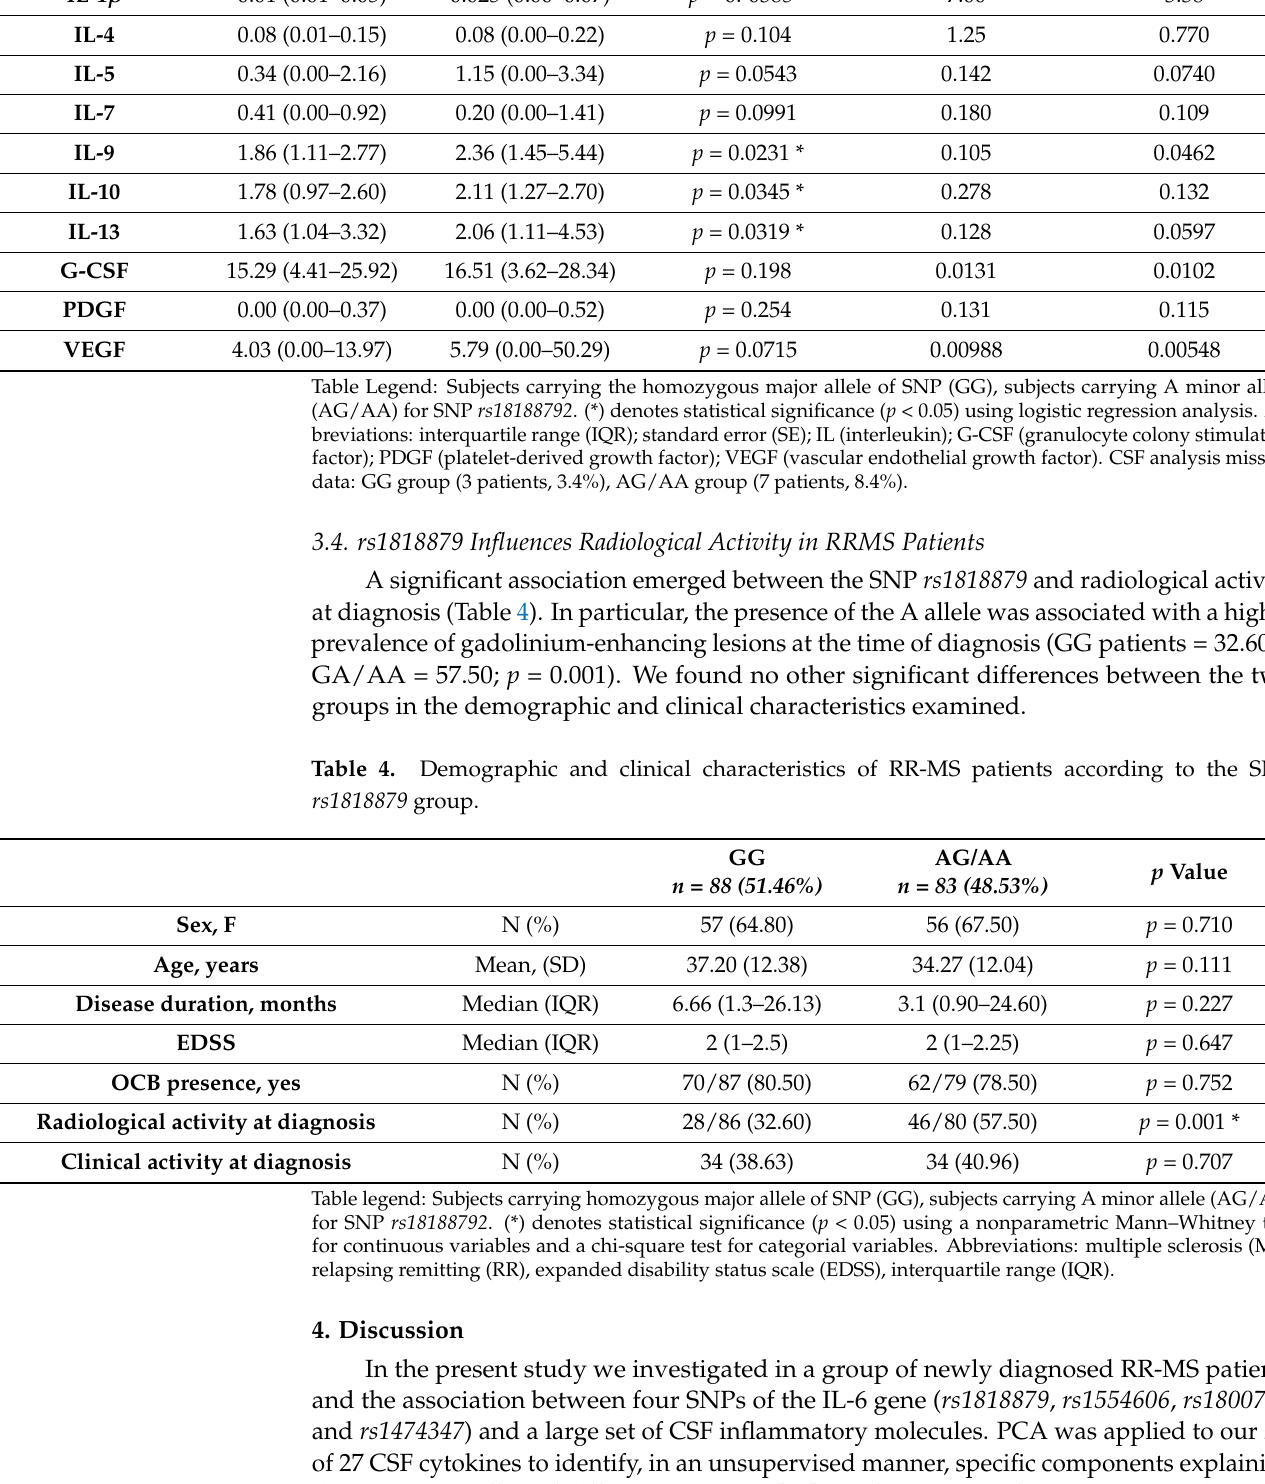
Table 3. Median (IQR) of cytokine levels with high loading in PC1 according to the SNP